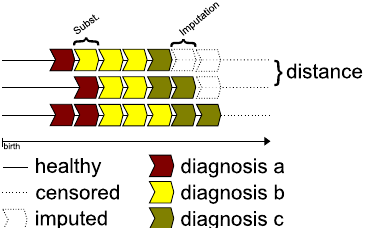
Fig. 3 Schematic of the sequence analysis procedure used to compute the dissimilarity of psychiatric comorbidity trajectories. Sequence dissimilarities were computed by alignment of the temporal sequence of diagnoses. Alignment could be obtained by substitutions, insertions, and deletions, which were each assigned a speci fi c cost. Censored sequences were imputed based on previous diagnoses and assigned a cost of the probability-weighted average of possible states. Supplementary Fig. S1 illustrates the most common trajectories among individuals with (Supplementary Fig. S4) and, based on these patterns, we per- formed post-hoc linear and logistic regression analyses, predict- ing, in series, the constituent diagnoses (logistic regression), their total count (linear regression), and age at fi rst diagnosis (linear regression), from each of the three principal MDS dimensions, independently. This showed that the fi rst dimension captured the total number of comorbid disorders (mean of 0.76 additional diagnoses per standard deviation (sd) increase), the second- dimension distinguished adult from childhood comorbid dis- orders (odds ratio (OR) per sd increase, mood disorders: 0.034;